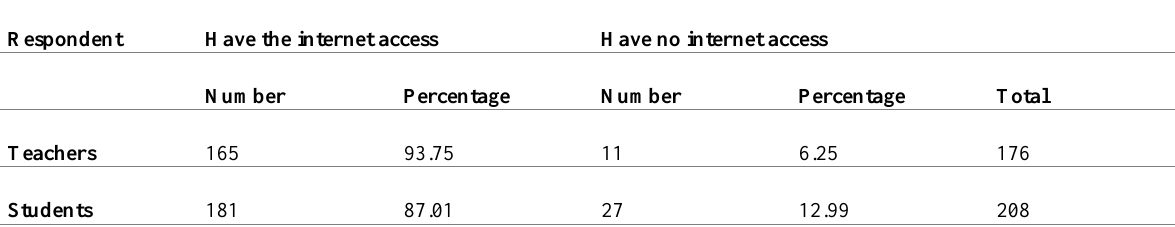
Table 6: Student and teacher have the internet